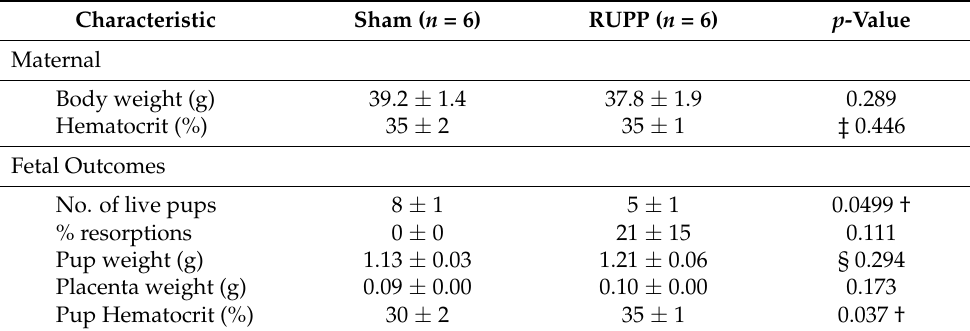
Table 1. General characteristics and pregnancy outcomes in RUPP